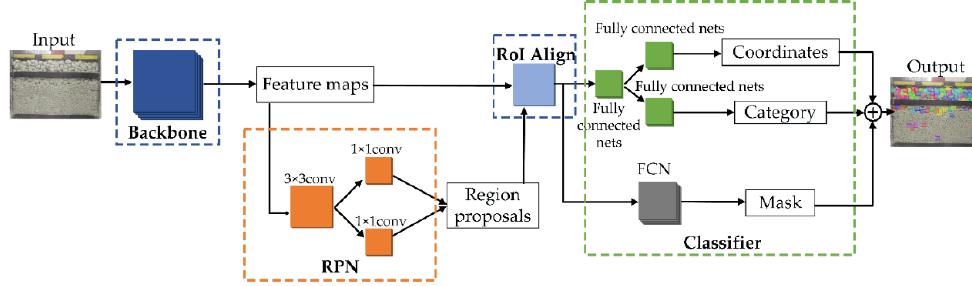
Figure 2. Mask R-CNN network structure.